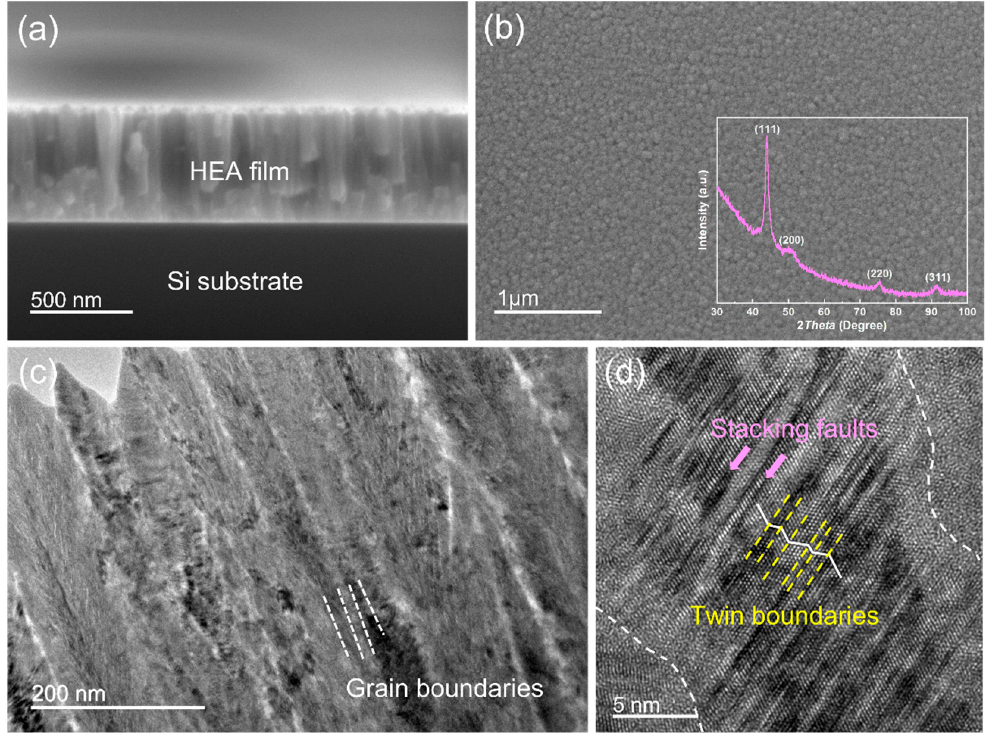
Figure 2. Characterization of CoCrFeNi HEA film. ( a ) The SEM cross-sectional observation of CoCrFeNi HEA film; ( b ) the SEM image of the HEA film surface inserted with the XRD patterns; ( c ) a representative TEM cross-sectional observation of CoCrFeNi HEA film; ( d ) the corresponding HRTEM image.